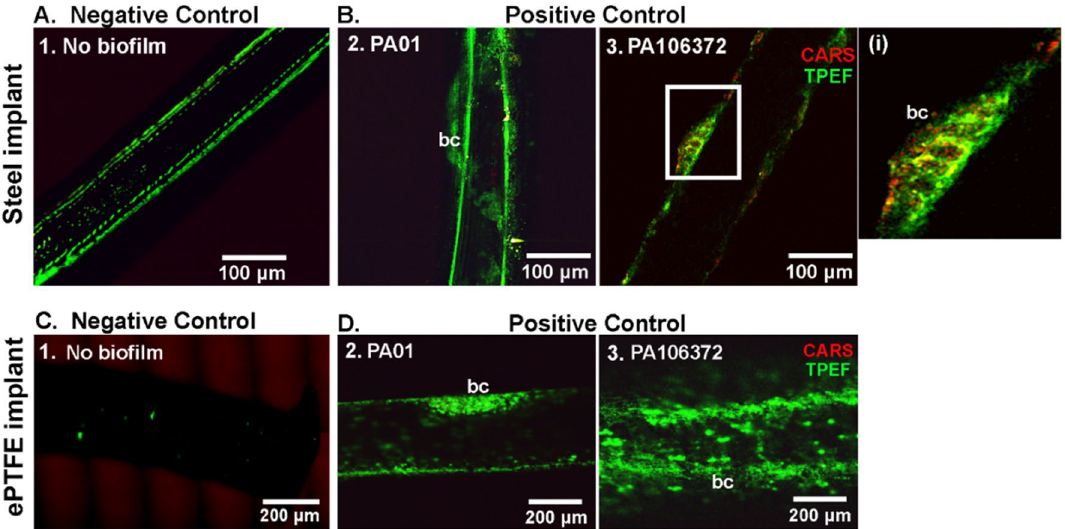
Figure 4. Multimodal images of the implants with biofilm formed in vitro by P. aeruginosa bacterial strains PA01 and PA106372. The steel implants were without biofilm ( A1 ) and with biofilm formed by the bacterial strains PA01 ( B2 ) and PA106372 ( B3 ). The square inset with a solid line in ( B3 ) is zoomed in and shown in ( i ). Bacterial clusters (bc) formed by the bacterial strains PA01 ( D2 ) and PA106372 ( D3 ) were observed on the ePTFE implant. Multimodal images with CARS (red) and TPEF (green) channels are overlayed in false